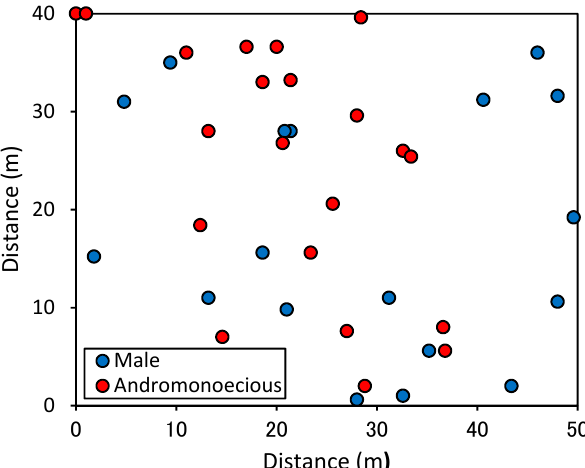
Figure 2. Site 2: distribution map of mature Fraxinus platypoda trees within the rectangular long-term study plot (50 × 40 m). Blue and red circles indicate 18 male and 21 andromonoecious mature trees, respectively.